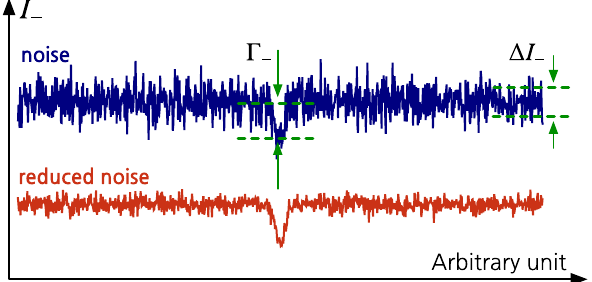
Figure 2. Illustration of the measurement outcomes of the intensity-difference I that would be obtained − with the noise (cid:31) I for a given state of light illuminated into an absorptive analyte with α . The presence of − the defect δα is represented by a dip with a depth of Ŵ in the noisy outcomes. If Ŵ is not large enough with − − respect to the noise (cid:31) I , the presence of the defect cannot be recognized or is hardly distinguished (e.g., upper − outcomes). Therefore, the use of a particular state of light yielding the reduced noise (e.g., lower outcomes) enables the defect to be more detectable under the noisy background.